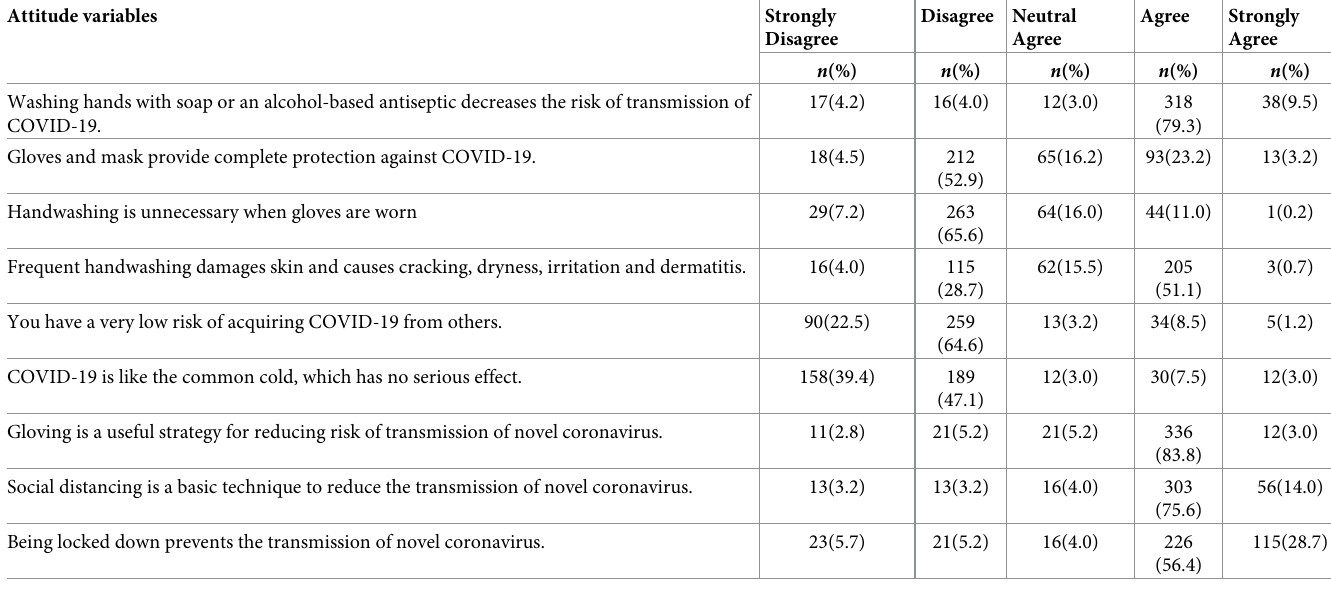
Disagree Neutral Disagree Agree